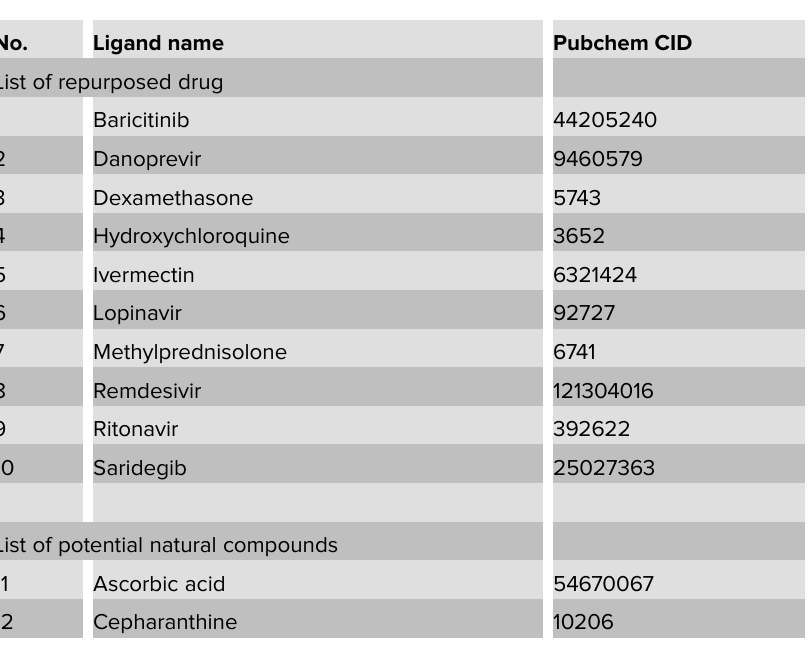
Table 2: Ligands to target Mpro